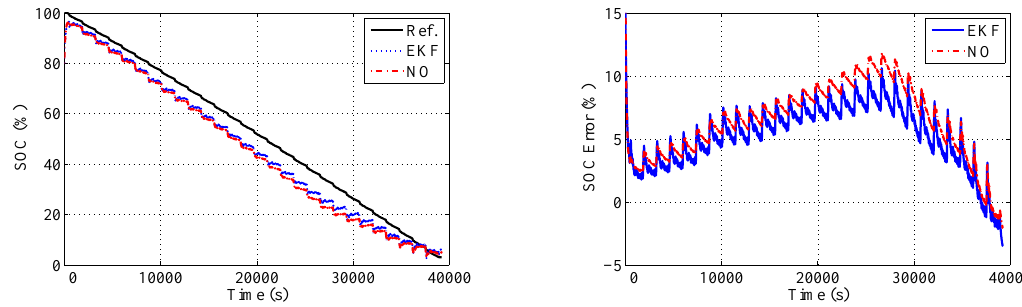
Figure 10. Robustness validation 3, model parameter uncertainties caused by